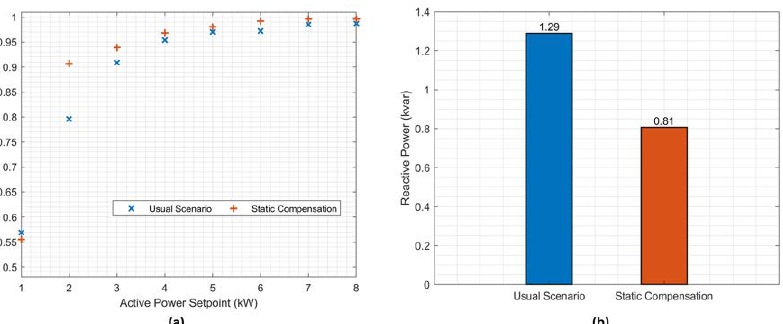
Figure 15. Comparison between usual and compensated PHIL simulation. ( a ) Improvement of power factor for different power set-points through compensation implementation. ( b ) Significant reduction of reactive power flow from the hardware under test